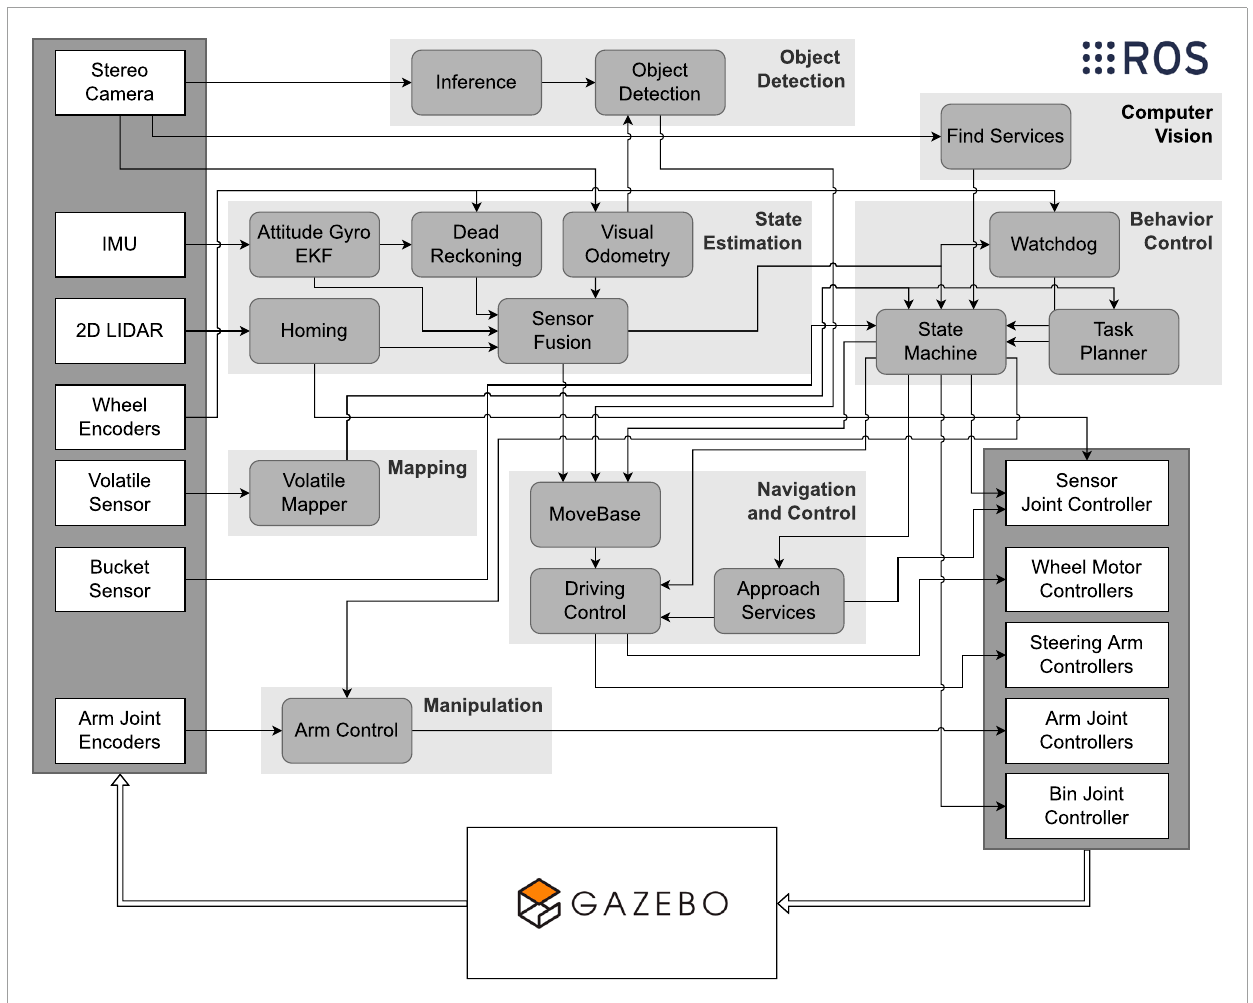
FIGURE 2 Systems architecture. The virtual environment, simulated using Gazebo, provides access to the sensor data illustrated by the white rectangles on the left side of the figure. The ROS nodes, represented by the rounded gray rectangles, were developed to control the robots and interact with each other to produce setpoints for the controllers made accessible from the